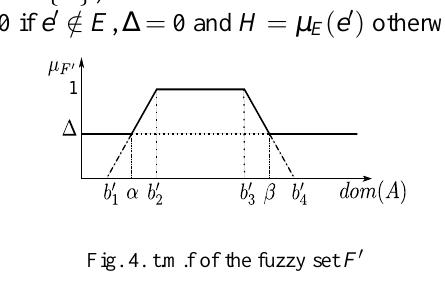
Fig. 4. t.m.f of the fuzzy set F ′